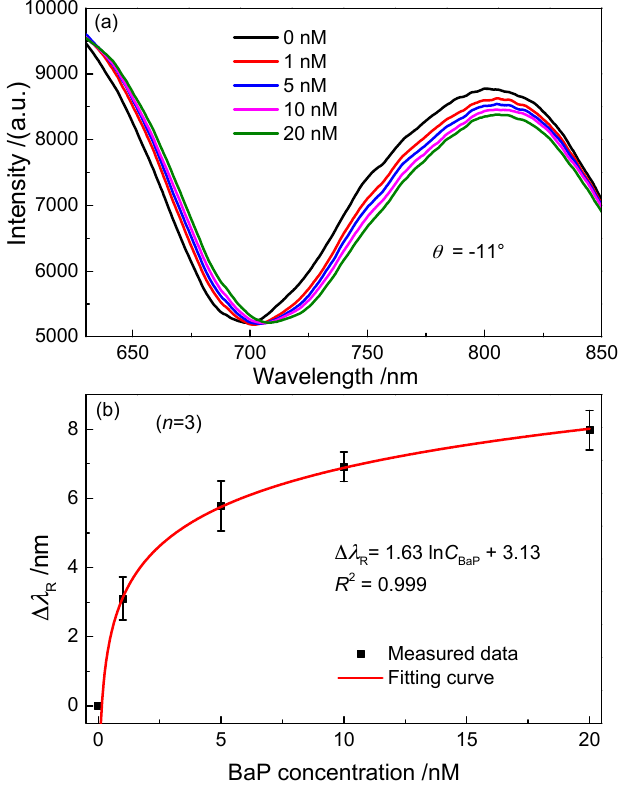
Figure 5. ( a ) SPR spectra measured at θ = − 11° with the hydrophobic NPG film in air after adsorption BaP molecules from a series of aqueous solutions with different BaP concentrations; ( b ) the resonance-wavelength shift as a function of the BaP concentration.